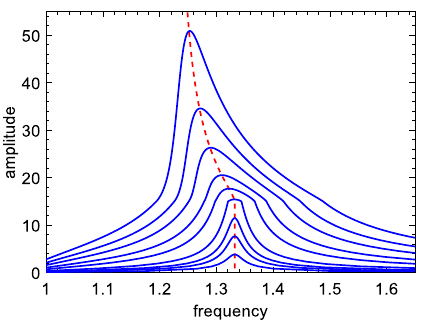
Figure 7. “ Skew ” phenomenon of the dry-friction system.